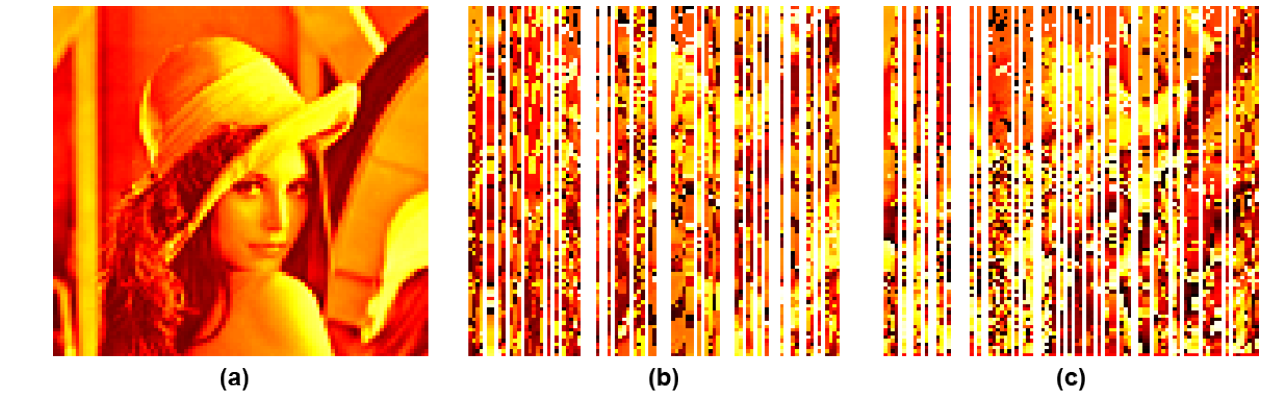
Figure 16. Received images after transmission between two computers. ( a ) Transmitted image. ( b ) Received image using FM-ACSK without a Hamming code. ( c ) Received image using FM-ACSK with a Hamming